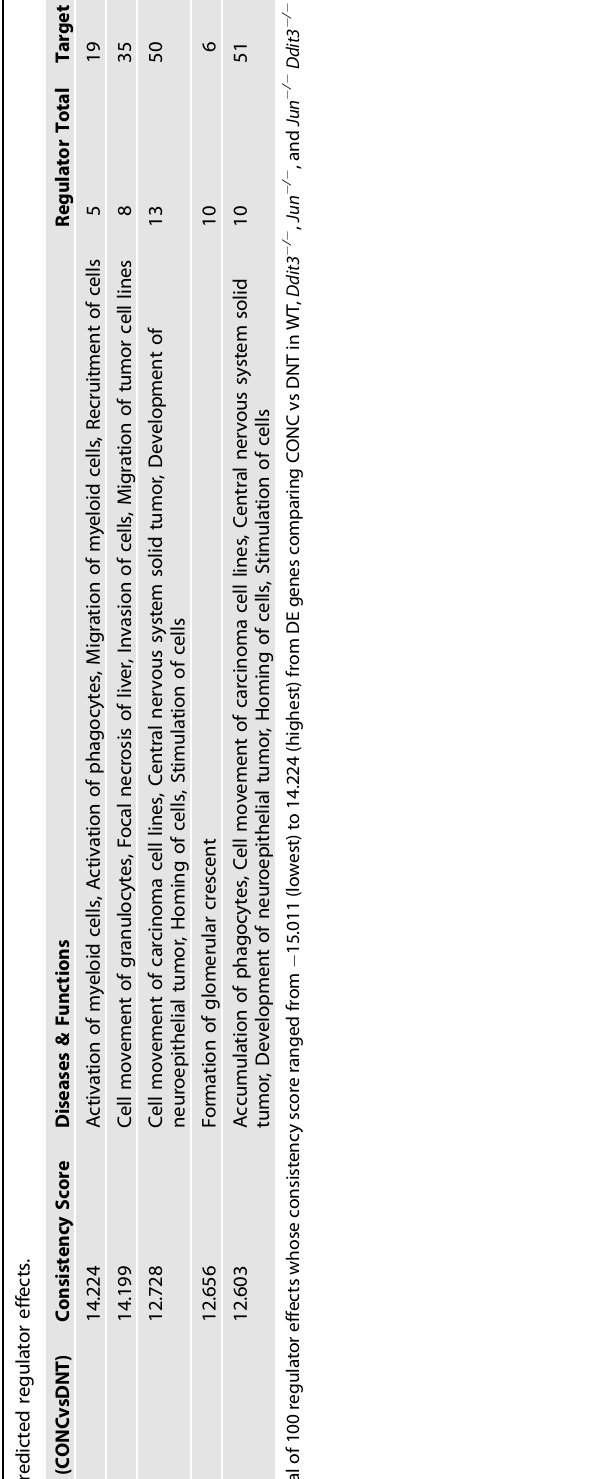
DATA AVAILABILITY The dataset(s) supporting the conclusions of this article is(are) included within the article (and its additional fi le(s)). The sequencing dataset discussed in this T